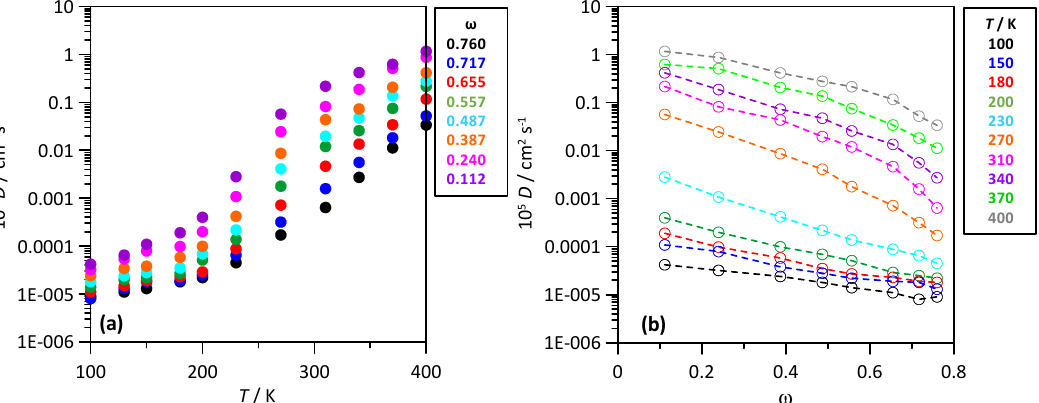
Figure 6. Self-di ff usion coe ffi cients of THAL, D , in ω THAL + (1- ω ) water mixtures. T stands for Figure 6. Self-diffusion coefficients of THAL, D , in ω THAL + (1- ω ) water mixtures. T stands for temperature and ω for THAL mass fraction. temperature and ω for THAL mass